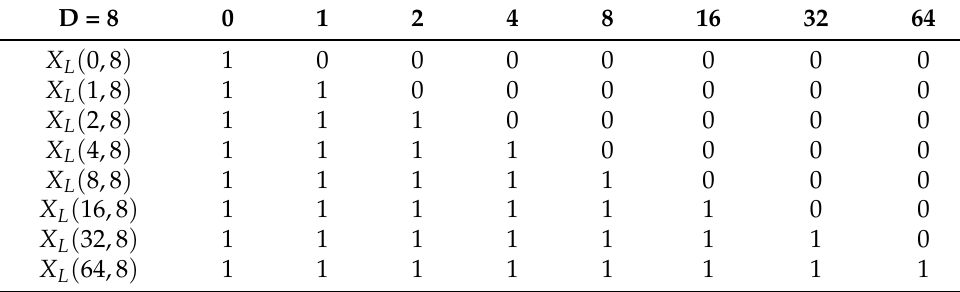
Table 2. All possible values encoded with method X L .